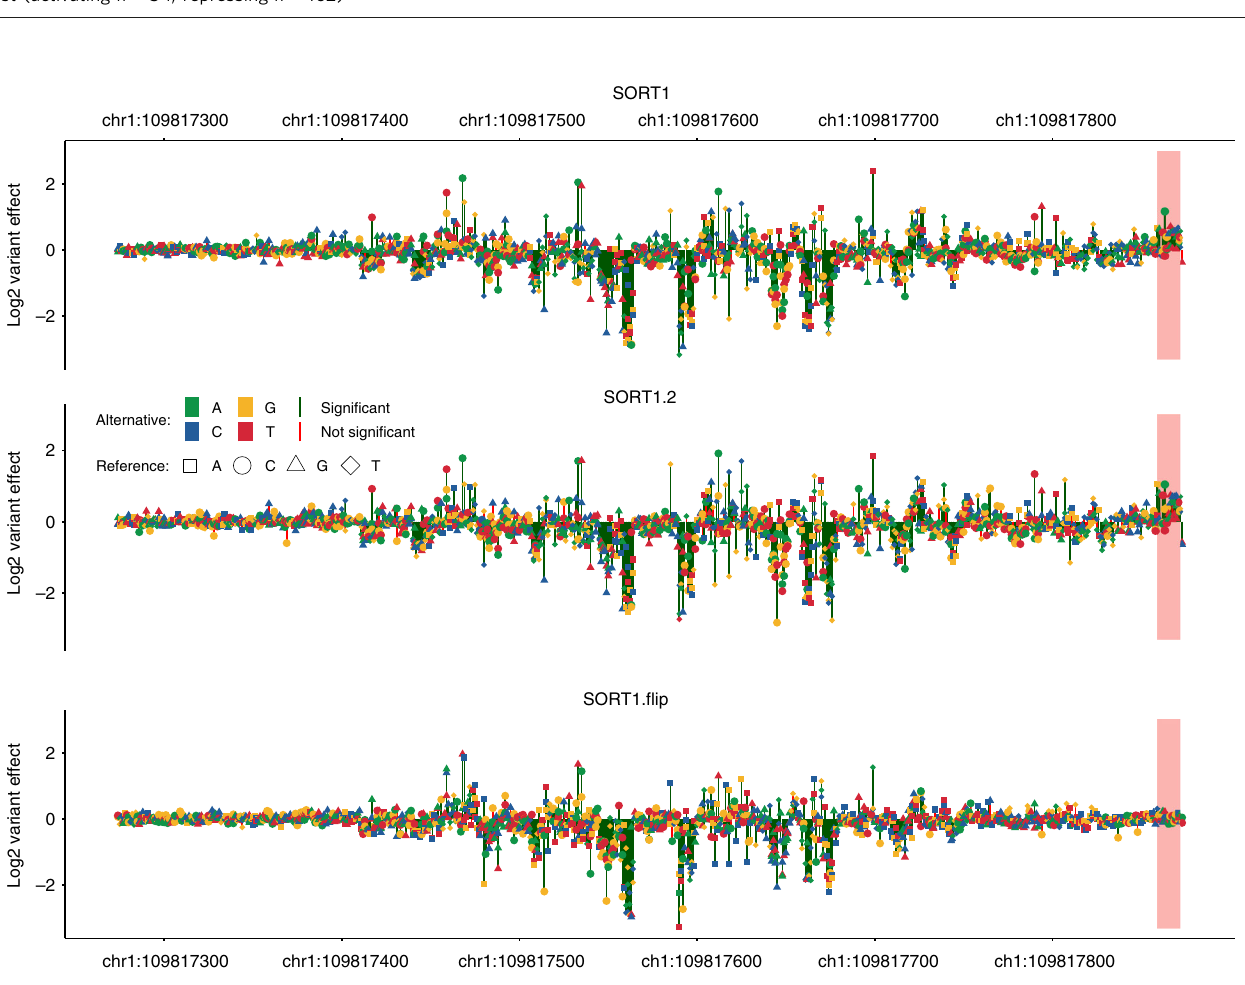
Fig. 2 Saturation mutagenesis MPRA of the cancer-associated TERT promoter. a Log 2 variant effect of all SNVs (min. ten tags required) ordered by their RefSeq transcript position in NM_198253.2 of TERT . Upper panel shows the TERT experiment in HEK293T cells and the lower in GBM (SF7996) cells, where the E2F repressor site is marked. A signi fi cance threshold of 10 − 5 was used (red vs. green vertical lines). b Expression pro fi le of TERT-GBM- siScramble (gray). Ninety fi ve percent con fi dence intervals of variants from TERT-GBM-siScramble (green) and TERT-GBM-siGABPA (red), that were signi fi cantly different between the two experiments, are overlaid. In addition, predicted ETS-related motifs in the reference sequence (green) or variant induced ETS-related motifs (blue) are marked. c Position weight matrix (PWM) score change of variants that show a signi fi cant difference between